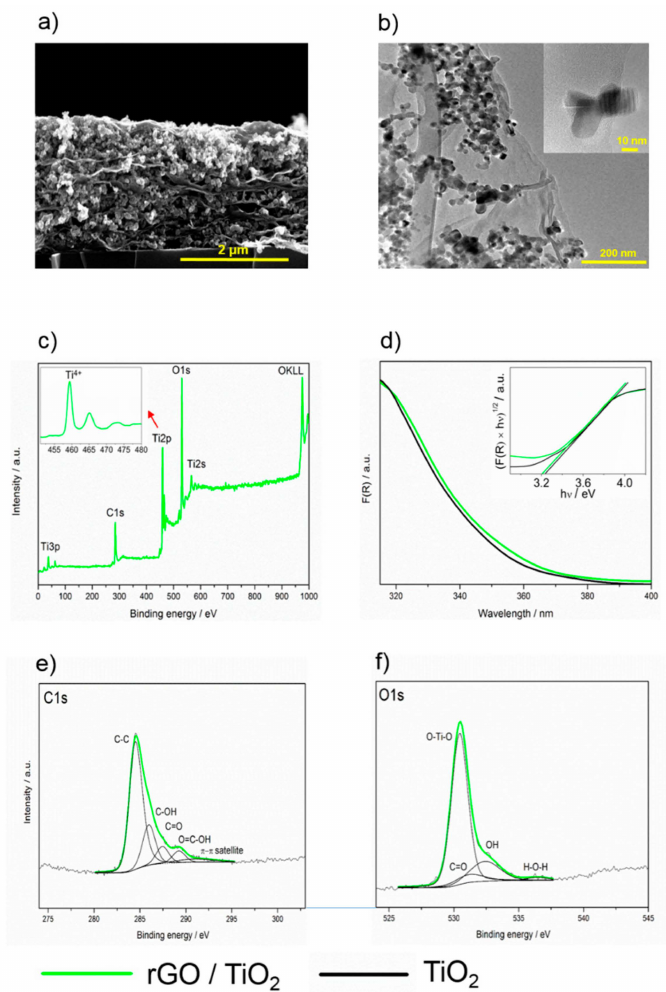
Figure 2. ( a ) SEM cross-section image of a composite layer containing TiO 2 and rGO, ( b ) HR-TEM image of the composite, ( c ) survey XPS spectrum of the rGO / TiO 2 composite layer, ( d ) UV / vis spectra of the rGO / TiO 2 and TiO 2 layers, ( e ) C1s and ( f ) O1s spectra rGO / TiO 2 composite